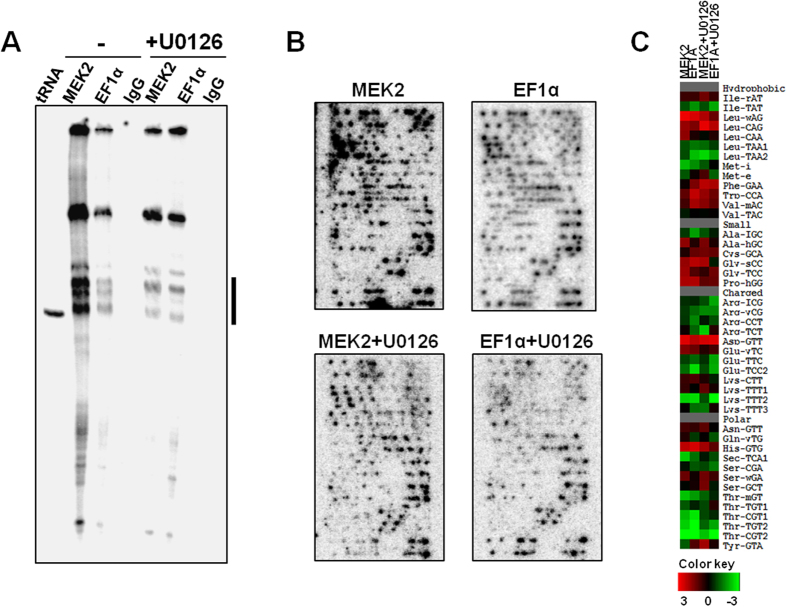
The MEK inhibitor U0126 decreases MEK2-tRNA interaction in pancreatic cancer cells.(A) CD18 pancreatic cancer cells growing on tissue culture plastic were treated with DMSO (vehicle control) or MEK1/2 inhibitor U0126 for 4 hours, exposed to UV to crosslink RNA and protein in live cells and then processed for CLIP-Chip using MEK2 antibody, EF1α antibody (positive control) or IgG antibody (negative control). Denaturing PAGE and tRNA microarray analysis demonstrating MEK2-tRNA interactions, with the indicated tRNA bands cut out for array analysis. (B) Semi-quantitative tRNA microarray analysis of tRNA species bound to MEK2/EF1α in CD18 pancreatic cancer cells. (C) Anticodon specific tRNA signals are calculated and expressed as log2(X), where X indicates values relative to samples treated with DMSO (vehicle control). Relative abundance of specific tRNAs are shown as heat map and are indicated with colors ranging from green (low) to red (high).